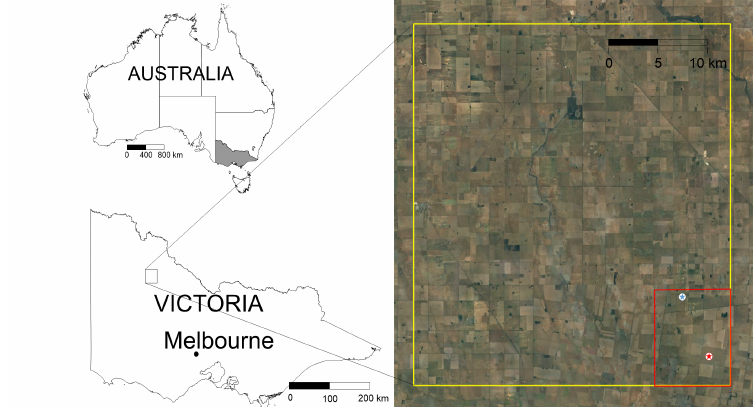
Figure 1. Location of field site in western Victoria, Australia. The yellow rectangle shows extent of broad-scale rover surveys (36 × 36km) and the red rectangle shows extent of intensive surveys (10 × 10km). Blue and red stars indicate the location of the Bishes and Bennetts cosmic-ray neutron sensors. Imagery data: Google, TerraMetrics